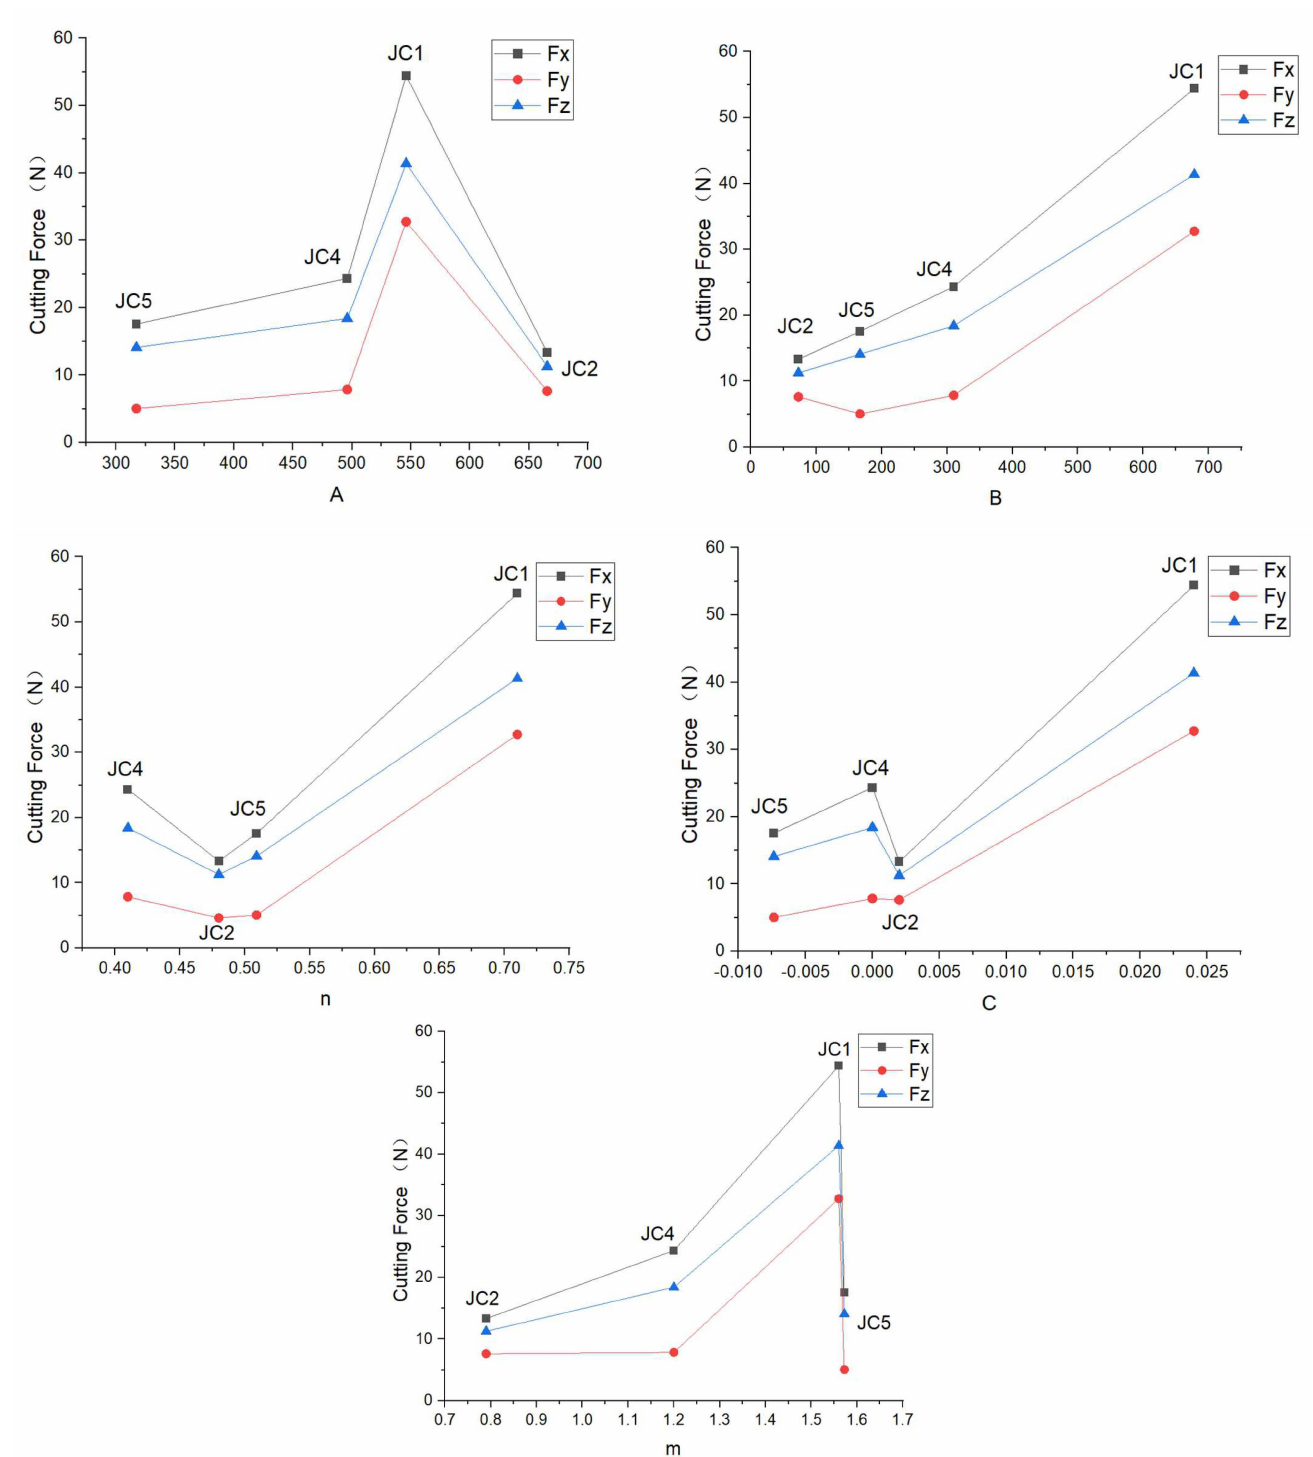
Figure 5. The influence of various parameters of Johnson − Cook constitutive model on cutting